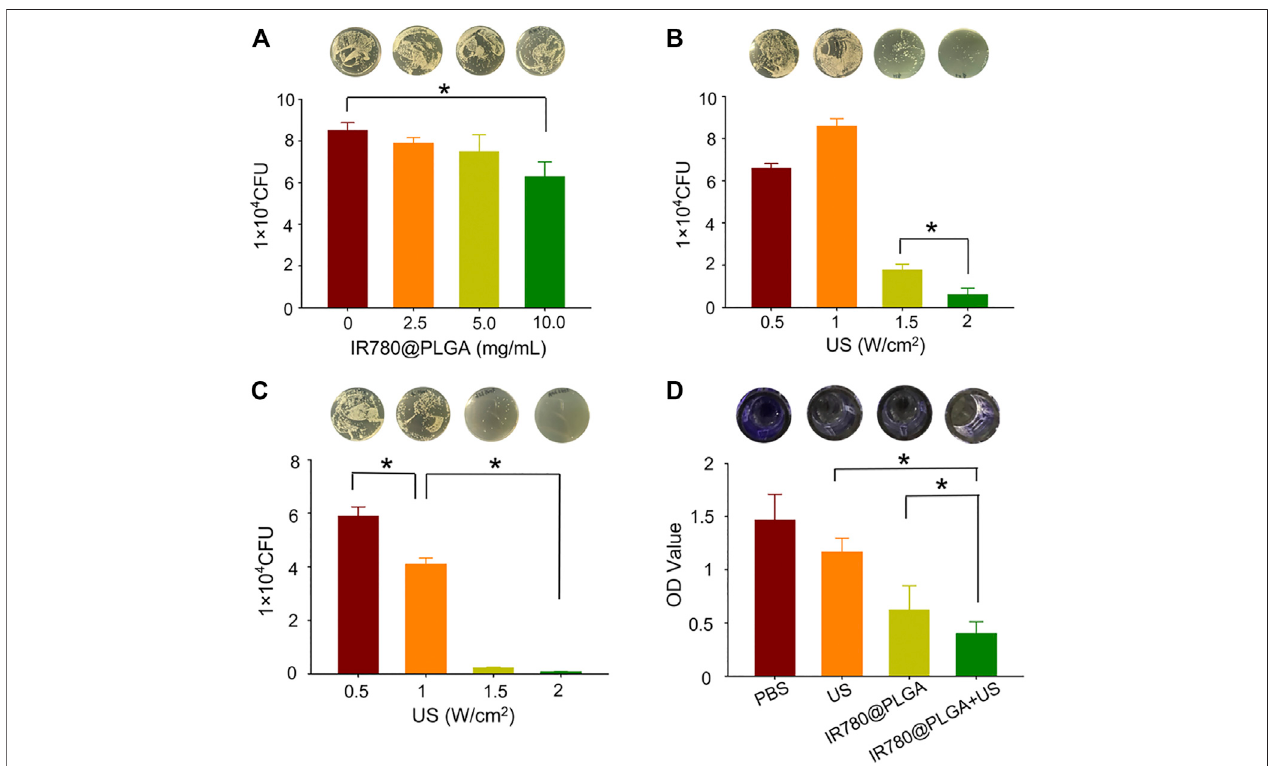
FIGURE 3 | (A) Plate-counting results of MRSA bacteria after coculture with IR780@PLGA nanoparticles at different concentrations for 24 h. (B) Plate-counting results ofMRSA bacteriaafter treated with US irradiation at different intensities. (C) Plate-counting results of MRSA bacteria after treated with the same concentration of IR780@PLGA nanoparticles (original concentration of 10 mg/ml) and different intensities of US irradiation. (D) Crystal violet staining results of the bio fi lm after different treatments for 36